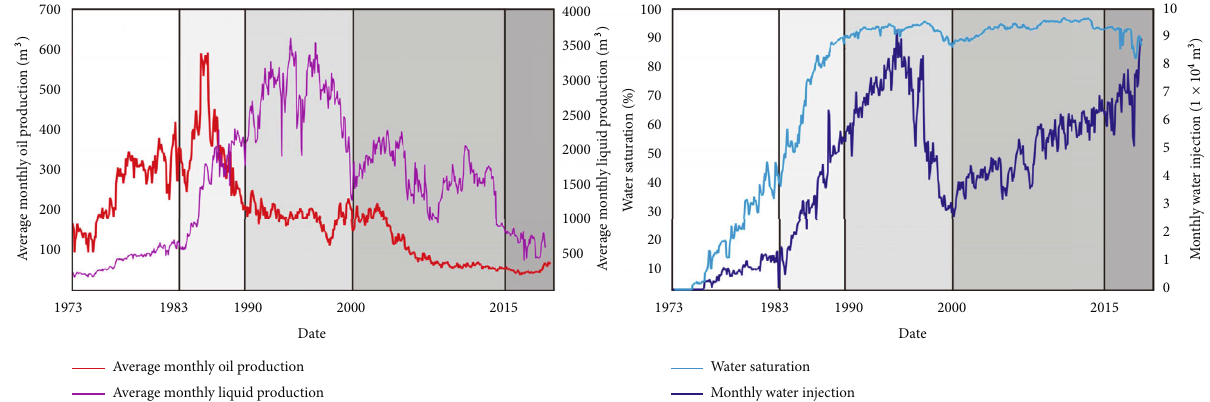
Figure 11: Overall production characteristic curve of